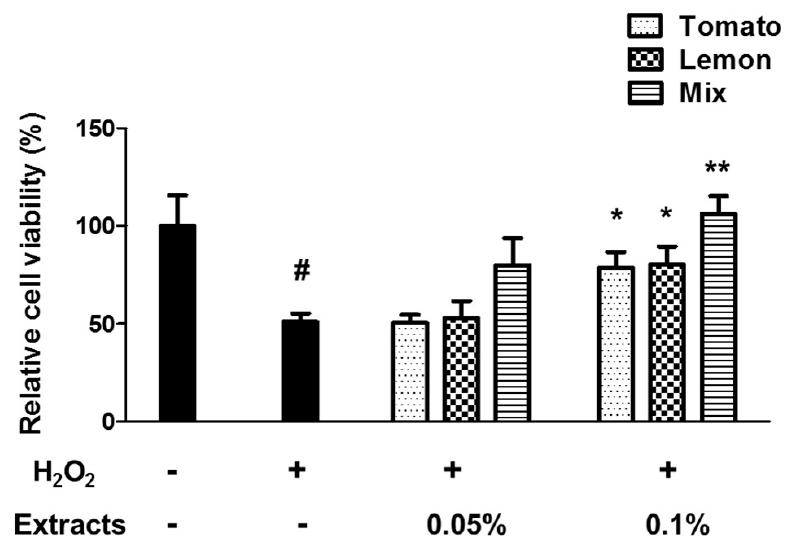
Figure 1. Protective effect of single extract with tomato or lemon and their mixture on cell viability. PC12 cells were pre-treated with tomato, lemon, or mixture extract at 0.05% and 0.1% concentrations for 24 hours, and were exposed to 100 µ mol/L H 2 O 2 for 30 min. Cell viability was measured using WST-1 assay. Relative cell viability compared to control (100%) was shown as percentage. # p < 0.05 vs. untreated control group, * p < 0.05, ** p < 0.01 vs. H 2 O 2 -treated group. T: tomato, L: lemon, T + L: mixture of tomato and lemon.